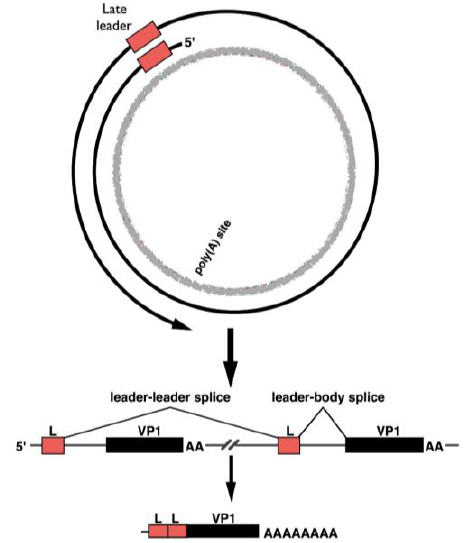
Figure 4. Late pre-mRNA splicing. Giant transcripts serve as precursors to late mRNAs. Processing of VP1 mRNA is shown. In multigenomic transcripts, leader (L) exons splice to one another, removing genome-length introns. Then, a leader-body splice can occur, coincident with polyadenylation. This results in mRNAs with tandem non-coding late leader exons at their 5′-ends.